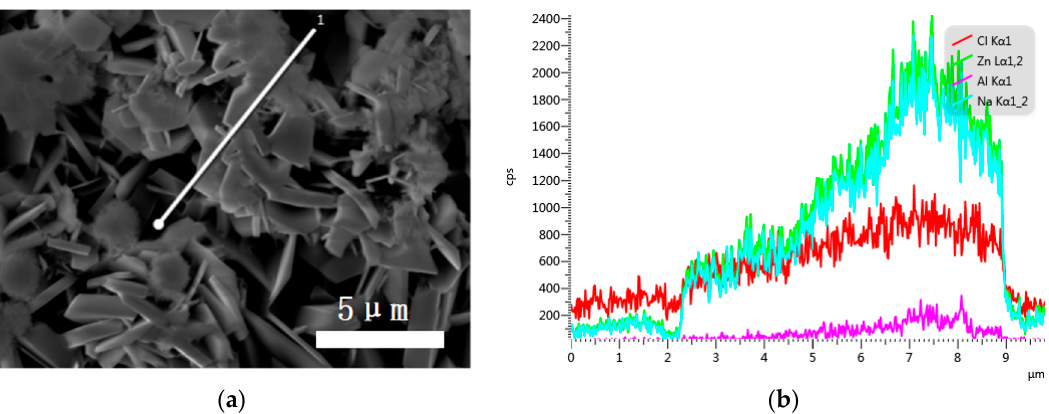
Figure 6. Coating EDS line scan after NSS test. ( a ) enlarged 1000 × view of the coating; ( b ) Coating EDS line scan element